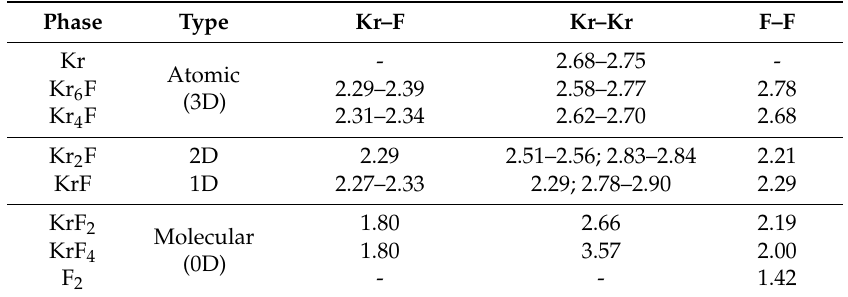
Table 1. Comparison of the closest Kr–F, Kr–Kr and F–F distances (in Å) for the lowest enthalpy structures of Kr m F n compounds at 150